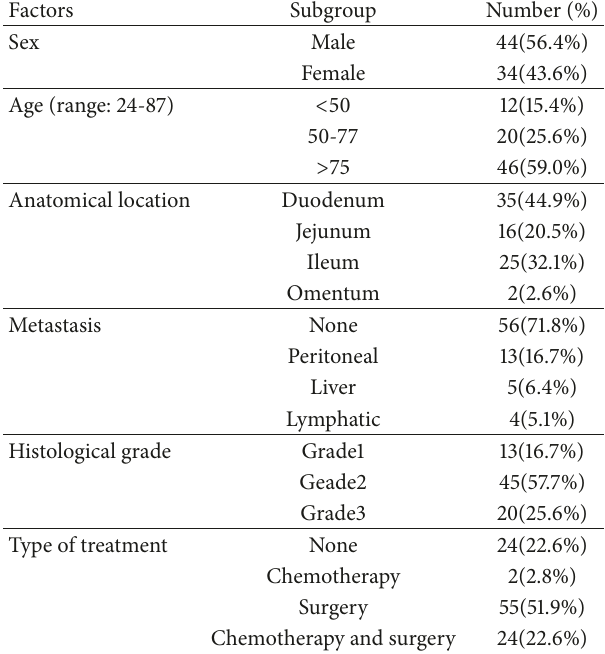
Figure 1: Kaplan-Meier curves illustrating overall survival of patients with MALToma who received chemotherapy after surgery (n =7) compared with patients who just had surgery (n =5).